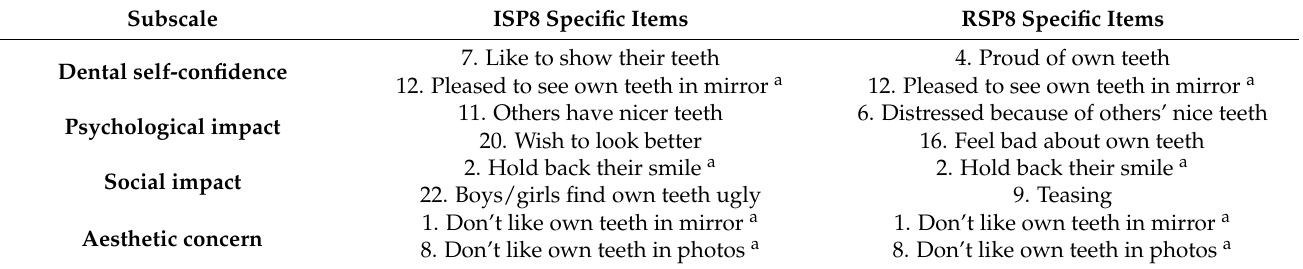
Table 1. Items of the simplified